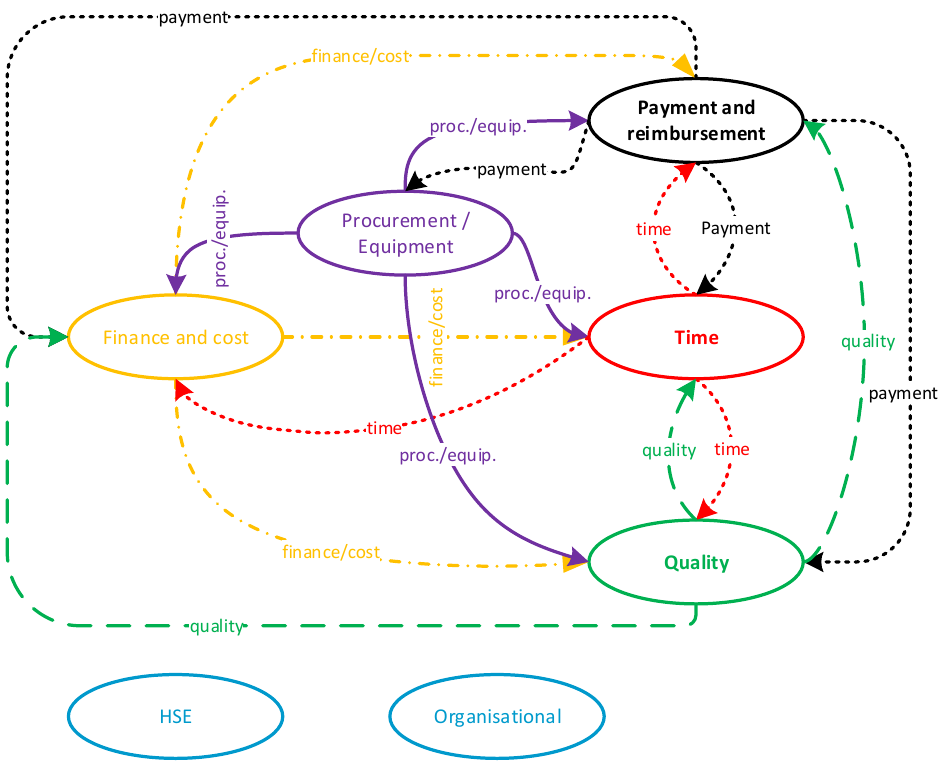
Figure 6. An Analytical Network Process of an effective relationship between seven most-frequent factors based on value threshold defined in terms of the DEMATEL method.